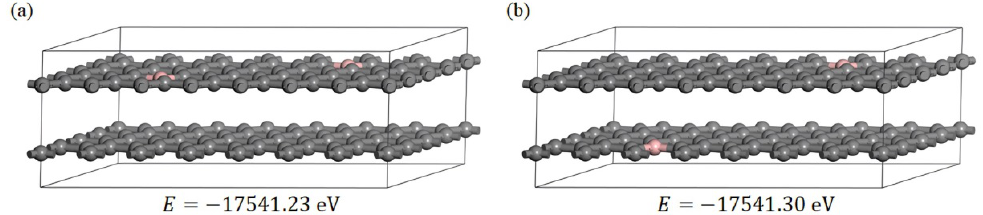
Figure 4. ( a , b ) two boron-doped graphite models, in which the pink atoms are boron and the grey atoms are carbon; E is the total energy of the models after optimization of the geometry. Table 3. Calculated interlayer spacings (d 002 ) of pristine graphite and model (b). Sample I.D.